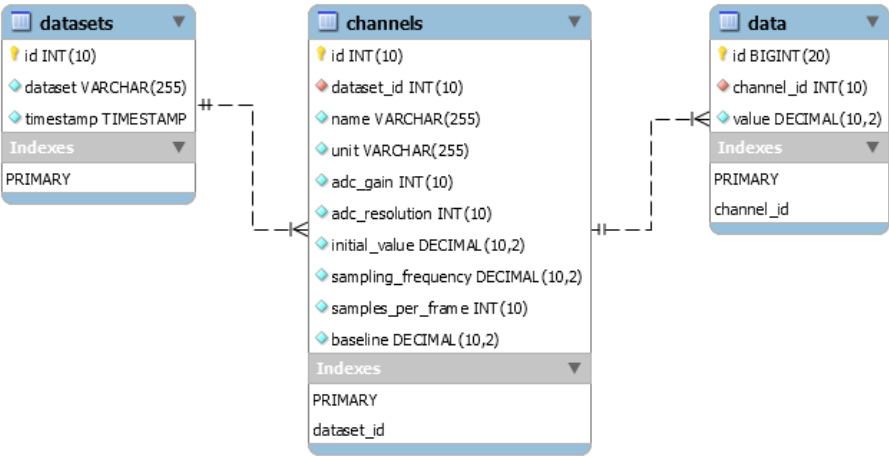
Figure 7. MySQL database used for performance